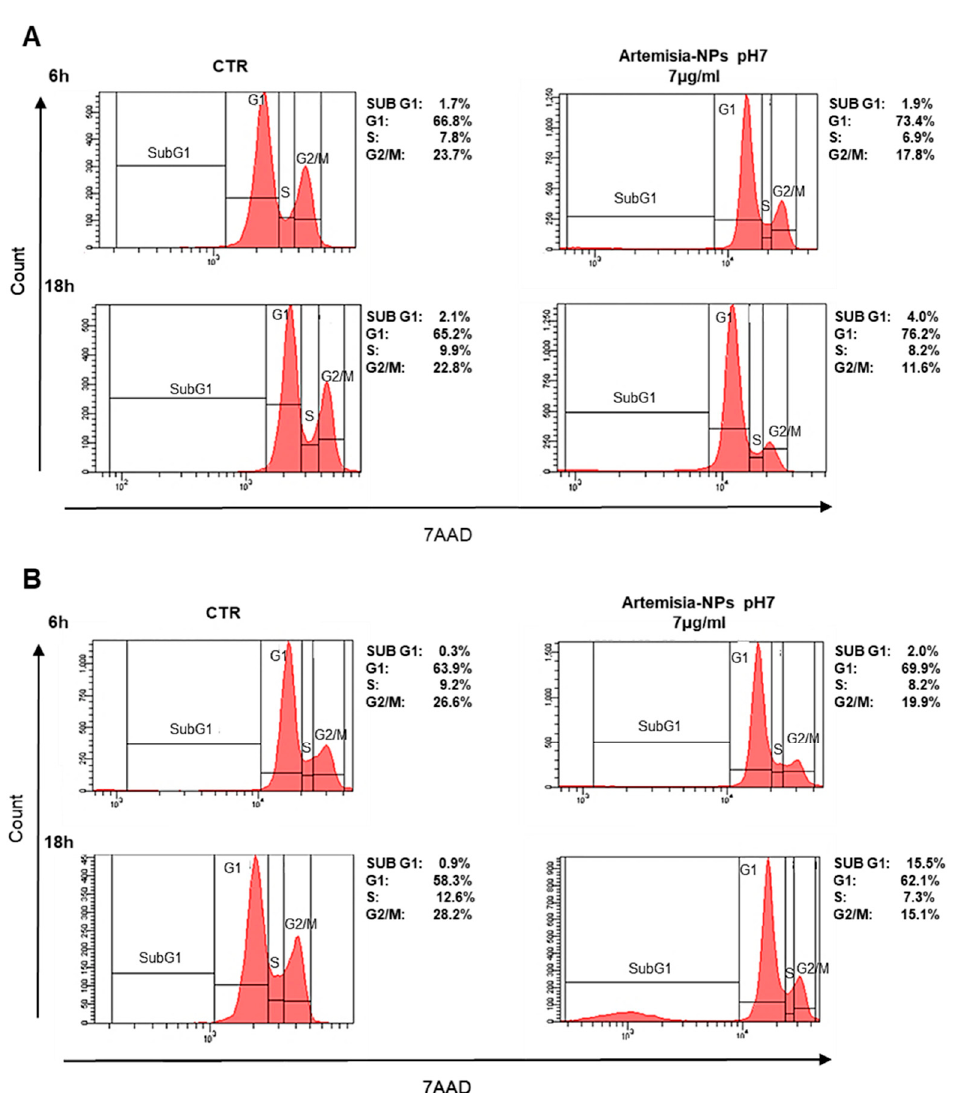
Figure 4. Cell cycle analysis. ( A ) HeLa cells were treated with 7 µg/mL of Artemisia–AgNPs pH 7 or left untreated. The cell cycle was evaluated after 6 h and 18 h by flow cytometry. ( B ) MCF-7 cells were treated to the same condition as HeLa and cell cycle effects were evaluated by flow cytometry.